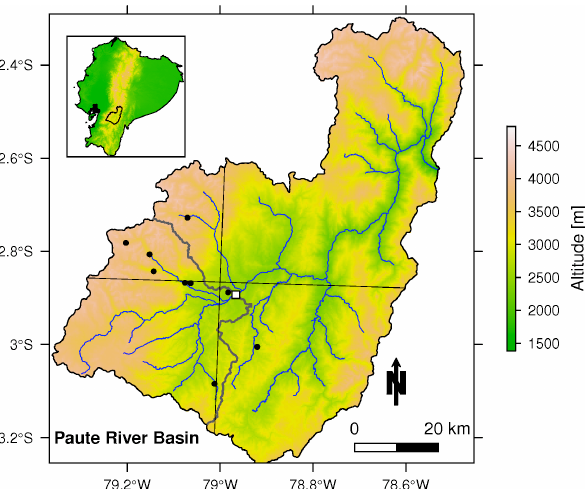
Fig. 1. Location of the Paute river basin and the Tomebamba sub- basin (delimited in grey). (cid:3) =Discharge station; • =Rain gauges. The grid corresponds to the PRECIS